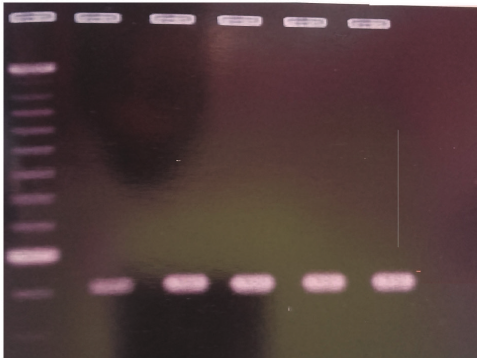
Figure 2: Gel documentation for rrs genes (five different samples) encoding aminoglycoside modifying